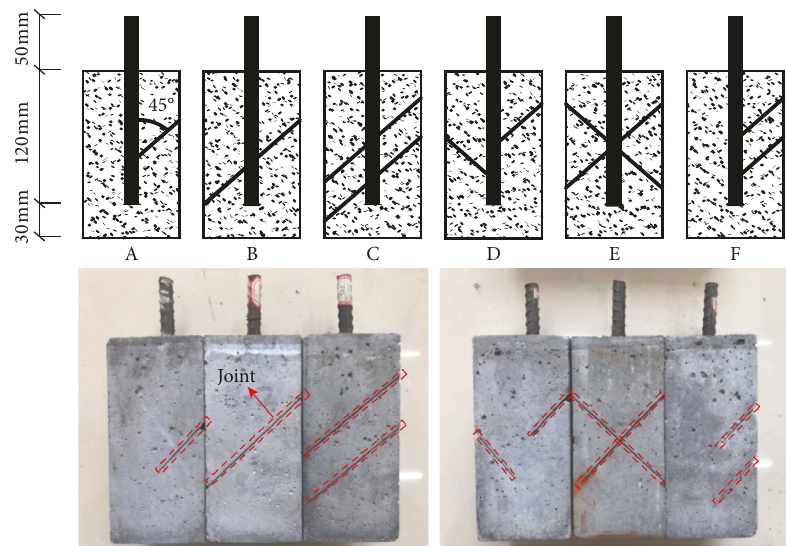
Figure 1: Size and joint distribution of specimens.